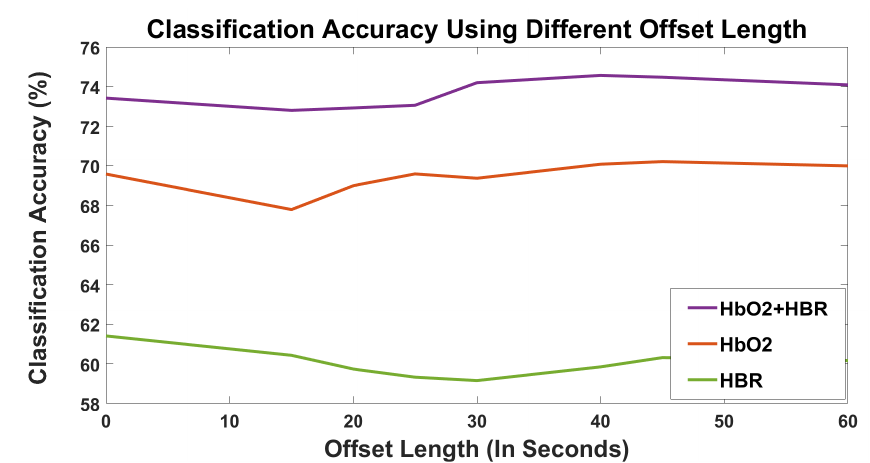
Figure 7. Classification Accuracy Using Different Offset